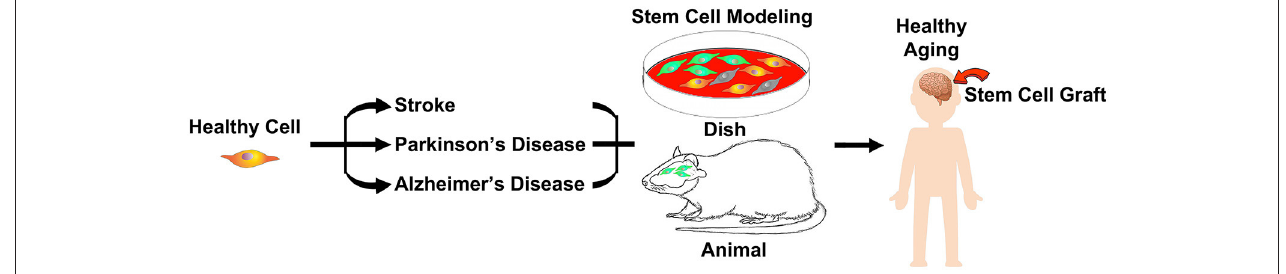
FIGURE 1 | During aging and disease states, such as stroke, Parkinson’s disease and Alzheimer’s disease, brain cells become vulnerable to injury, which can be captured in a pertri dish or animal models. Stem cell therapy stands as a robust approach in harnessing healthy